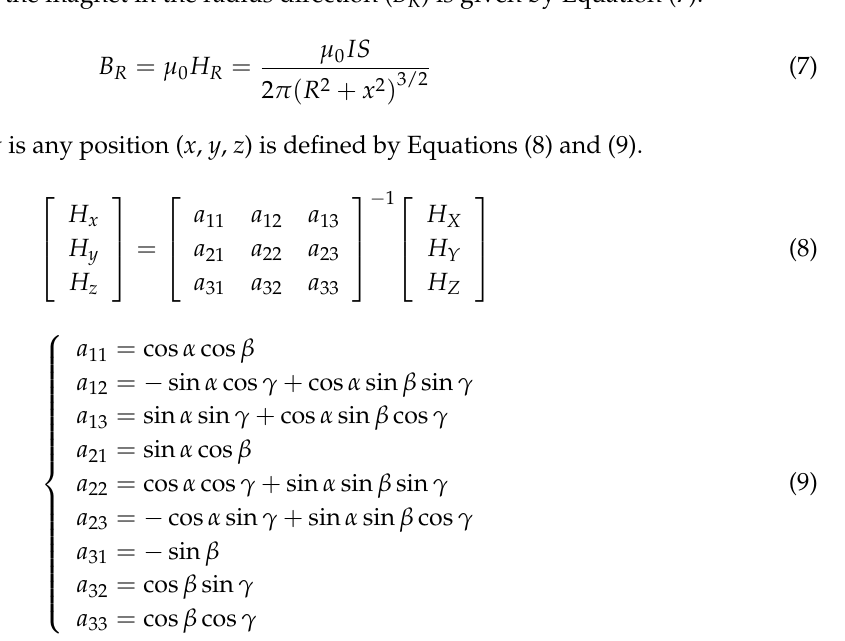
x -axis, y -axis and z -axis.